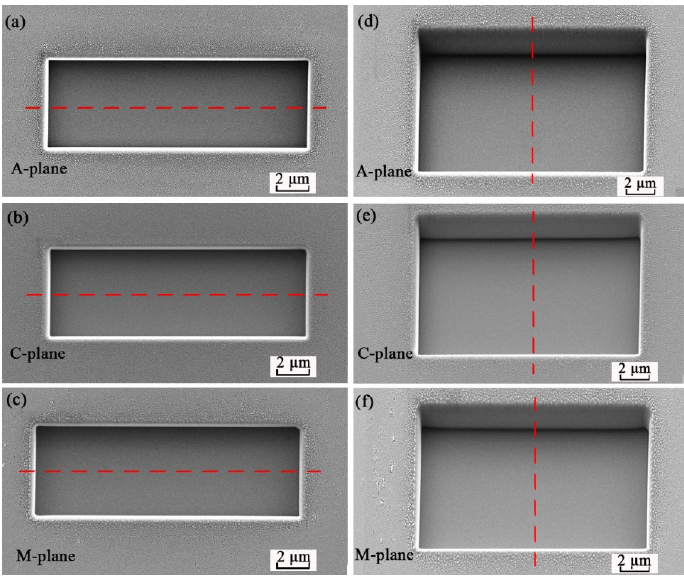
Figure 2. SEM images of the pits on the sapphire with different orientations taken at a sample tilt angle of 0° ( a – c ) and 30° ( d – f ), respectively.